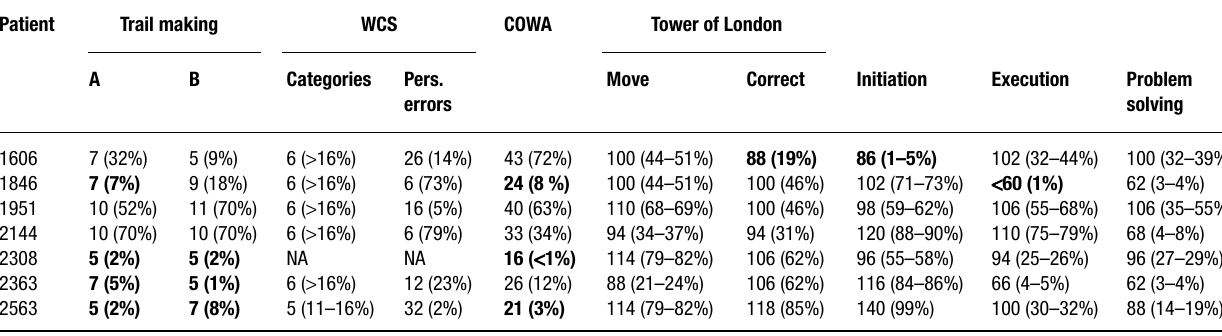
Table 2 | Scores on various tests of frontal function for each